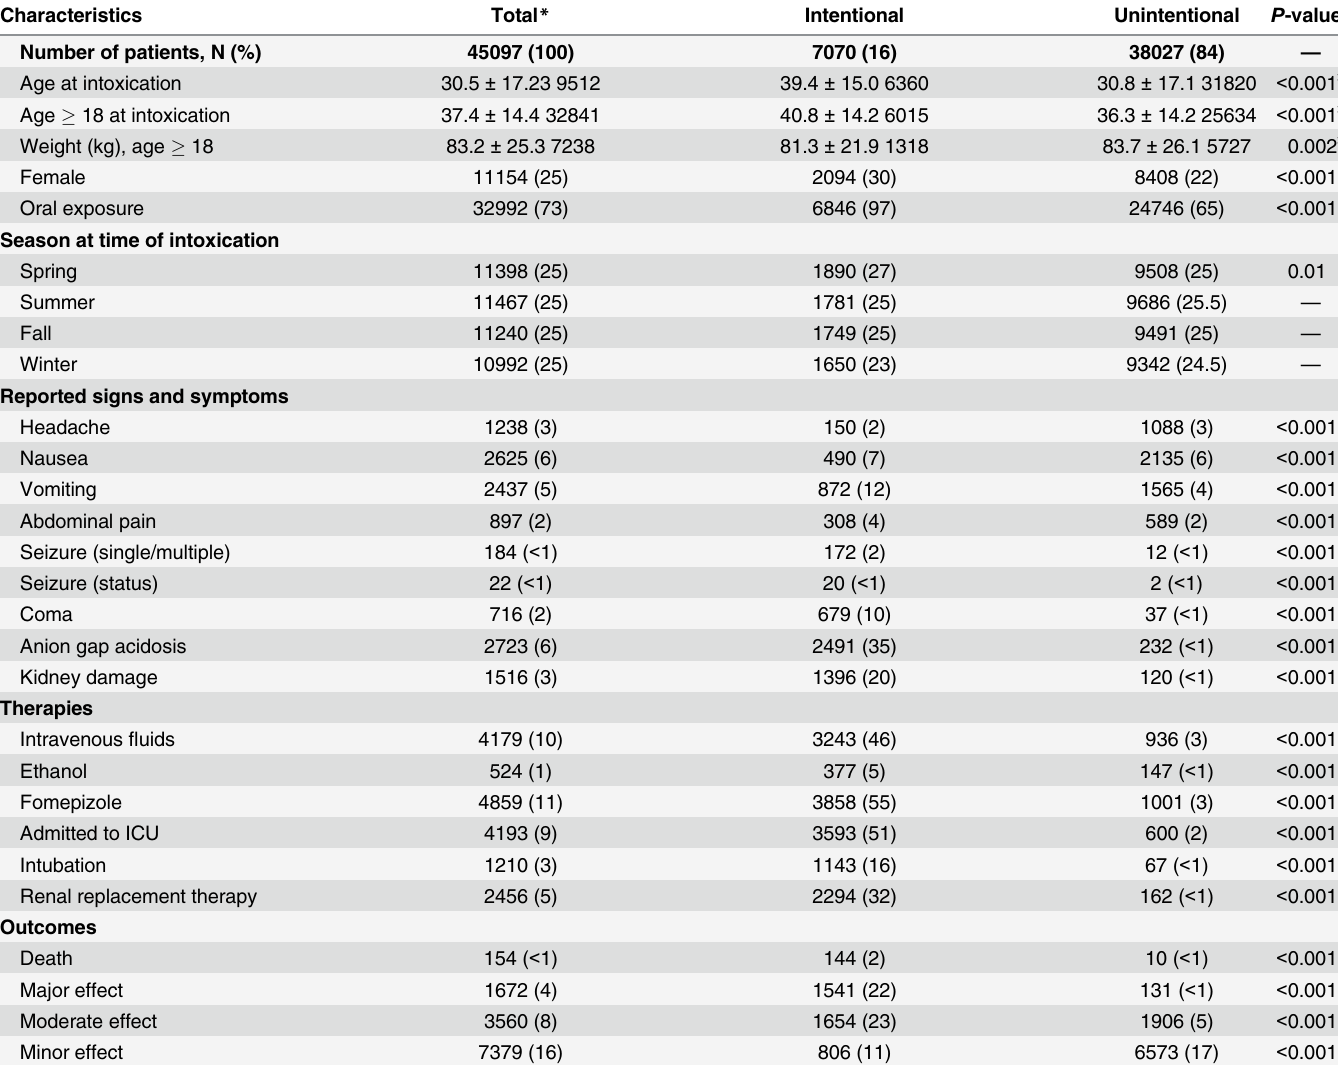
Table 1. Baseline Characteristics of Patients with Ethylene Glycol Poisoning in the United States.